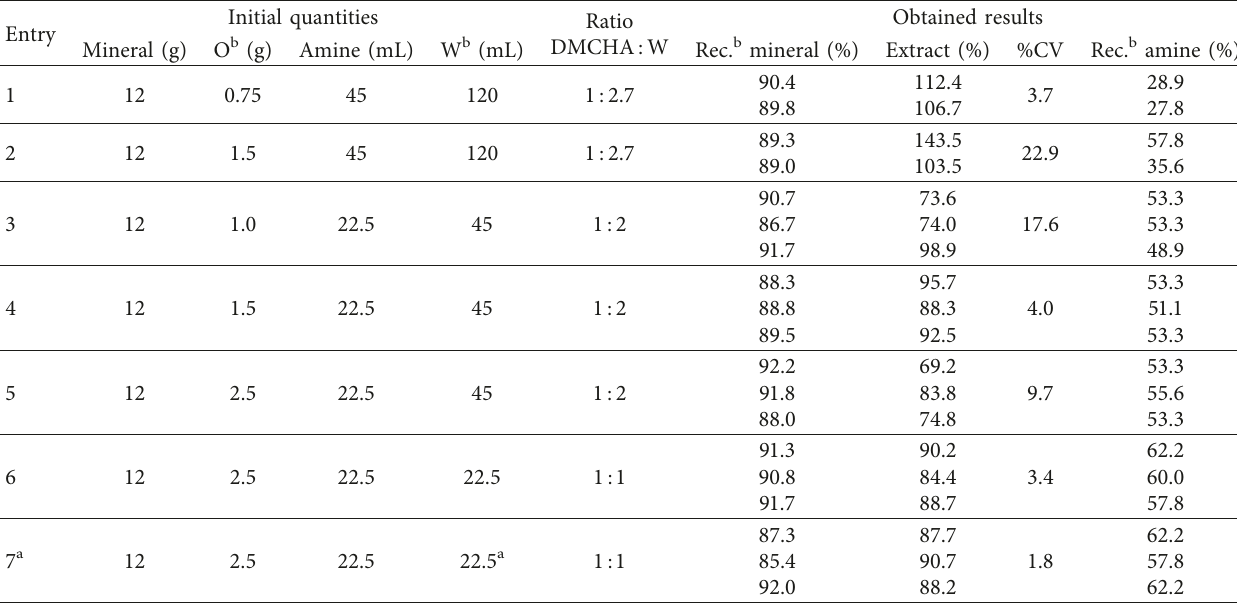
Figure 4: SEM micrographs for (a) NWM (26x), (b) NWM (200x), (c) WM (26x), and (d) WM (200x). Table 2: Results obtained from crude oil extraction process using DMCHA as